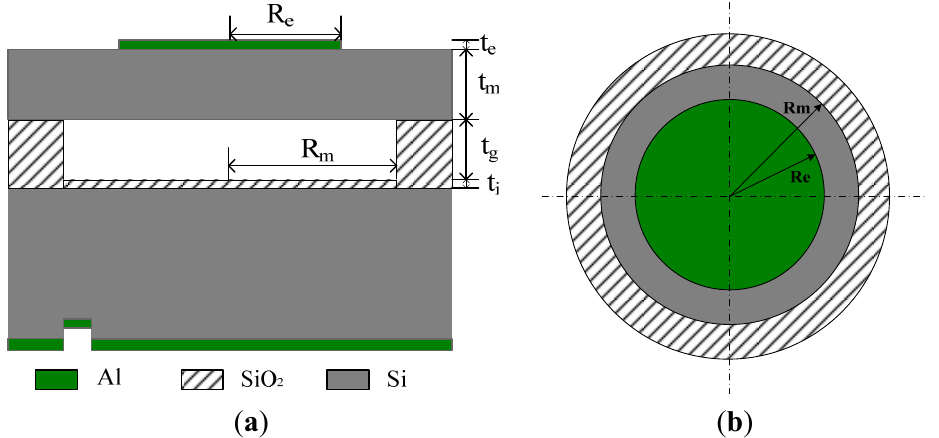
Figure 1. Capacitive micromachined ultrasonic transducer (CMUT) structure of micro vibration unit: ( a ) profile view of CMUT micro vibration unit; ( b ) top view of CMUT micro vibration